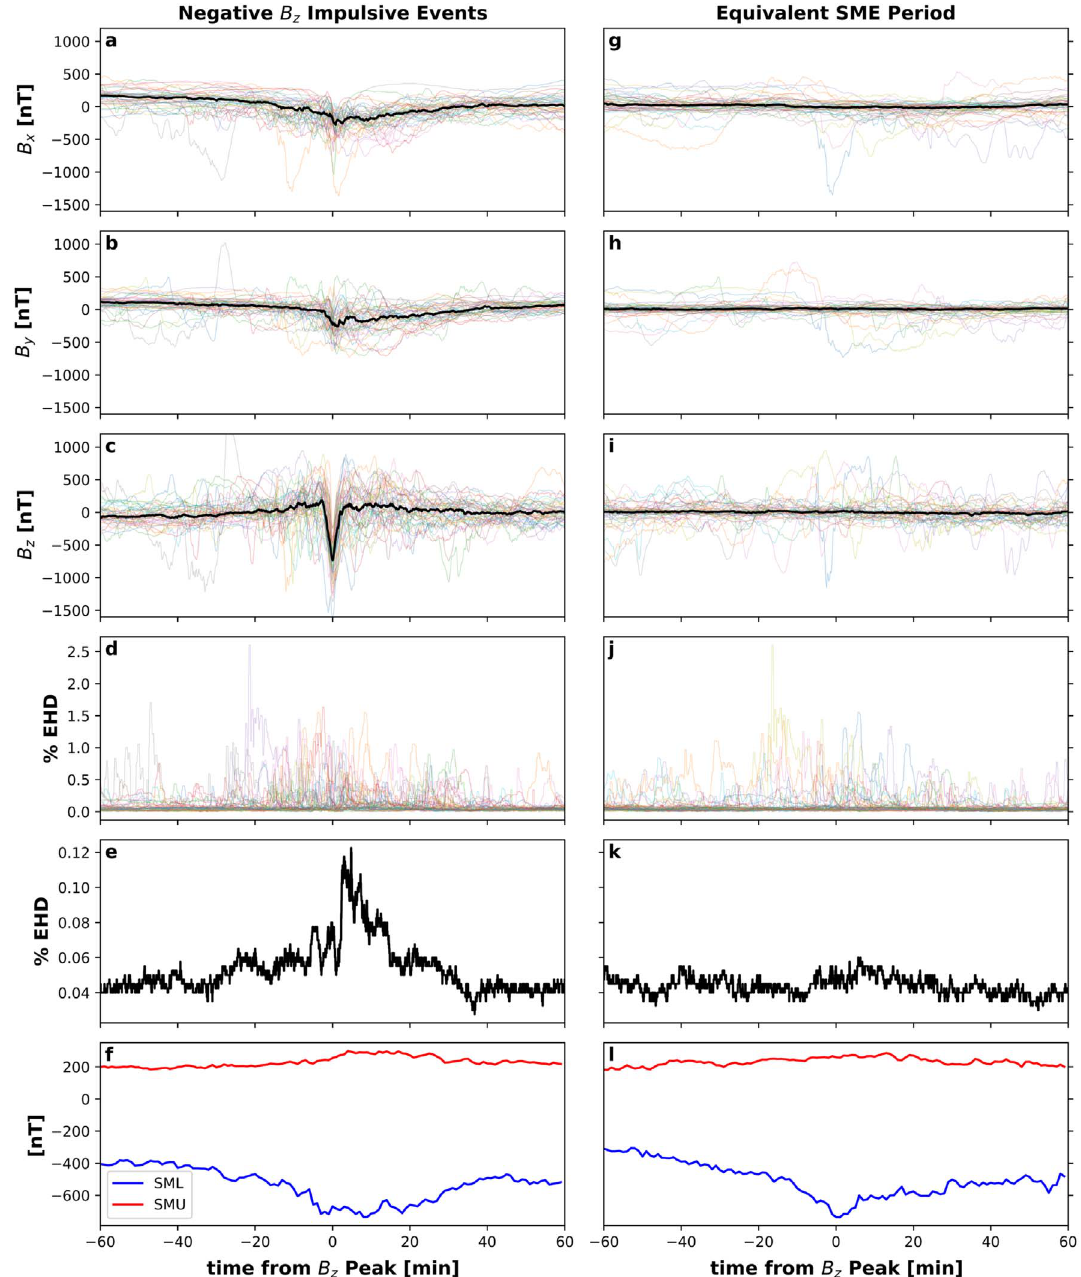
Fig. 6. Left (a)-(f): Superposed epoch analysis of magnetometer data from Inukjuak QC and EHD from the Tilly substation in the Hydro- Québec network (median values in bold black). Superposed epoch trigger is the negative B z extremum for the 50 largest negative B z impulsive events. Median SMU (red) and SML (blue) for these 2-h windows are shown in the bottom panel. Individual EHD traces are colorized in d , median values shown in e . Right (g)-(l): Inukjuak QC magnetometer readings for equivalent SME periods at the B z extrema, and corresponding median EHD values at the Tilly substation. All SME values have been minimum EHD subtracted for each two-hour period. Events without HD data from Tilly were not used (5 of 50